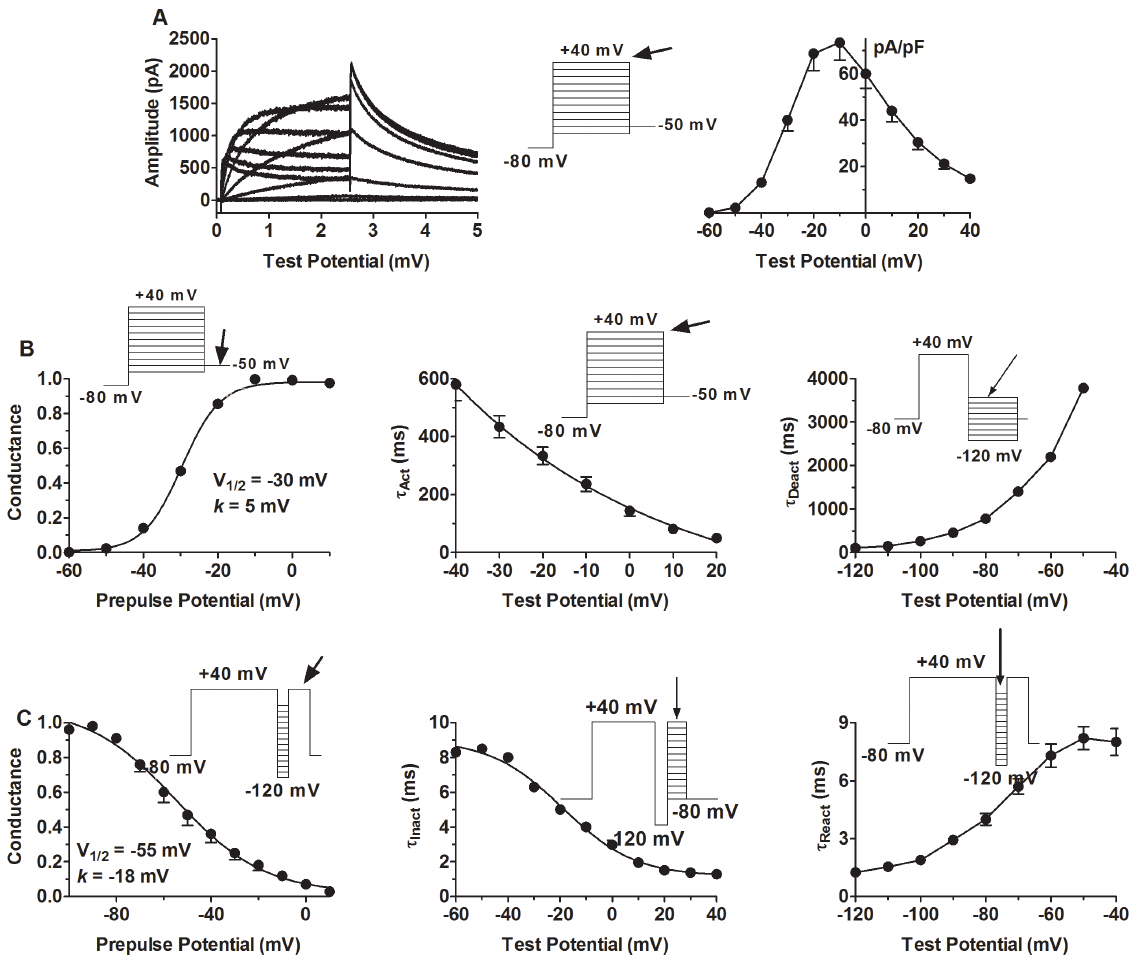
Figure 2. Characterization of I HERG with conventional square-pulse protocols. A , left panel: a typical example of I HERG currents recorded with the voltage protocol shown in the inset; right panel: the averaged current density-voltage relationship of I HERG (n=12).. B , left: steady-state voltage-dependent activation curves. The activation curves were constructed by plotting the conductance G as a function of depolarizing potentials. G was calculated by normalizing the tail currents at 2 50 mV by dividing the amplitude of the tail currents measured at various antecedent depolarizing potentials by that of the tail current at + 40 mV. Symbols are mean of experimental data and lines represent the Boltzmann fit: G/ G max =1/{1 + exp[( V 1/2 2 V )/ k ]}, where G max represents the maximal conductance at + 40 mV, V 1/2 is a half-maximal activation voltage, and k is a slope factor. Middle: the apparent activation time constants ( t act ) of HERG channels were determined by the single exponential fit to the step I HERG during depolarizing pulse to 0 mV. Right: the apparent deactivation time constants ( t deact ) of HERG channels. The decaying phase of the tail I HERG elicited at various hyperpolarizing/repolarizing steps (from 2 120 mV to 2 50 mV), following a depolarizing prepulse to + 40 mV, were fit by the single exponential to obtain t deact . C , left: the steady-state voltage-dependent inactivation was assessed by the voltage protocol shown in the inset. The steady-state inactivation curves were constructed by plotting the channel availability or conductance G as a function of hyperpolarizing potentials. G was calculated by normalizing the tail currents elicited at + 20 mV by dividing the amplitude of the tail currents measured at various antecedent hyperpolarizing potentials by that of the tail current at 2 100 mV. Symbols are the mean of experimental data and lines represent the Boltzmann fit: G / G max =1/{1 + exp[( V 1/2 2 V )/ k ]}, where G max represents the maximal channel availability at 2 100 mV, V 1/2 is the half-maximal inactivation voltage, and k is the slope factor. Middle: the inactivation kinetics ( t inact ) of HERG channels. The decaying tail currents recorded upon depolarization to various potentials ranging from 2 80 mV to + 40 mV to inactivate HERG channels, preceded by a 10-ms hyperpolarizing prepulse to 2 120 mV to let channels fully recover, were fit to the monoexponential function to obtain the values of t inact . Right: the reactivation time course ( t react ) determined with the same voltage protocol as that for steady-state inactivation. The monoexponential fit was applied to the activating phase of the tail I HERG evoked at various hyperpolarizing/repolarizing steps following the inactivation steps at + 40 mV. * p , 0.05 vs. Ctl; n=12